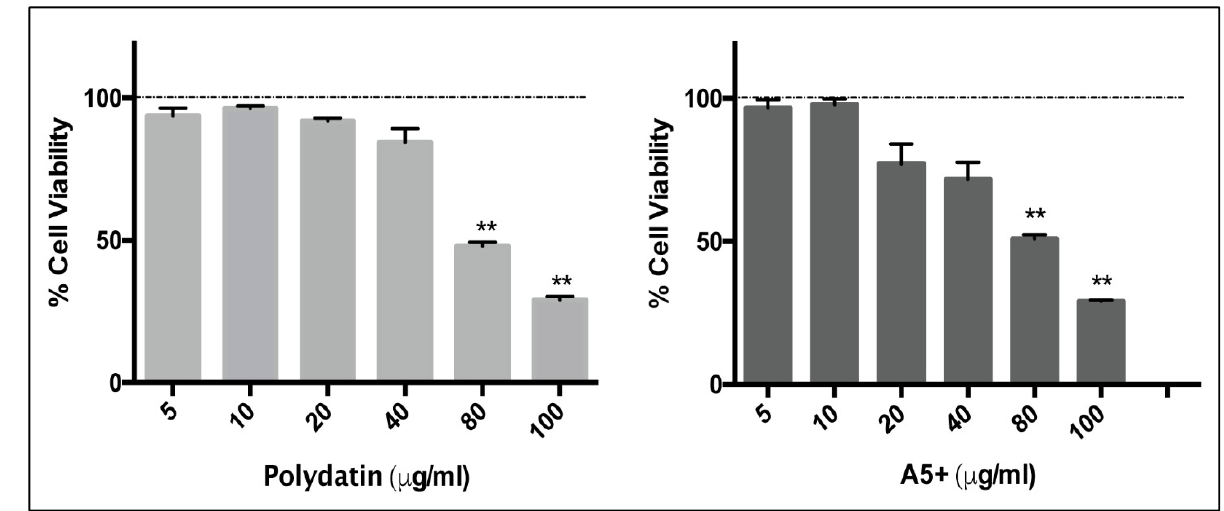
Figure 1. Polydatin and A5+ are toxic on Vero E6 cells only at higher concentrations. MTT assay on Vero E6 cell monolayer incubated with increasing concentrations (5–100 µg/mL) of Polydatin or A5+ compounds for 24 h. Cell viability was expressed as percentage (%) of treated cells compared to control cells treated with solvent dilutions (H 2 O or DMSO for Polydatin and for A5+ treatment, respectively). Data are mean ± SD from two technical replicates of one experiment of the two performed (** p < 0.001 vs. control solvent-treated cells, considered 100%, dashed line).